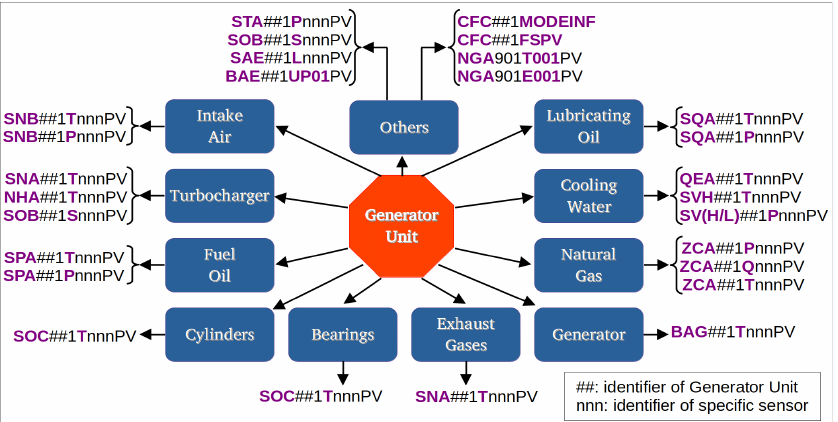
Figure 2. Diagram of a generator unity, divided into 11 subsystems (further divided into